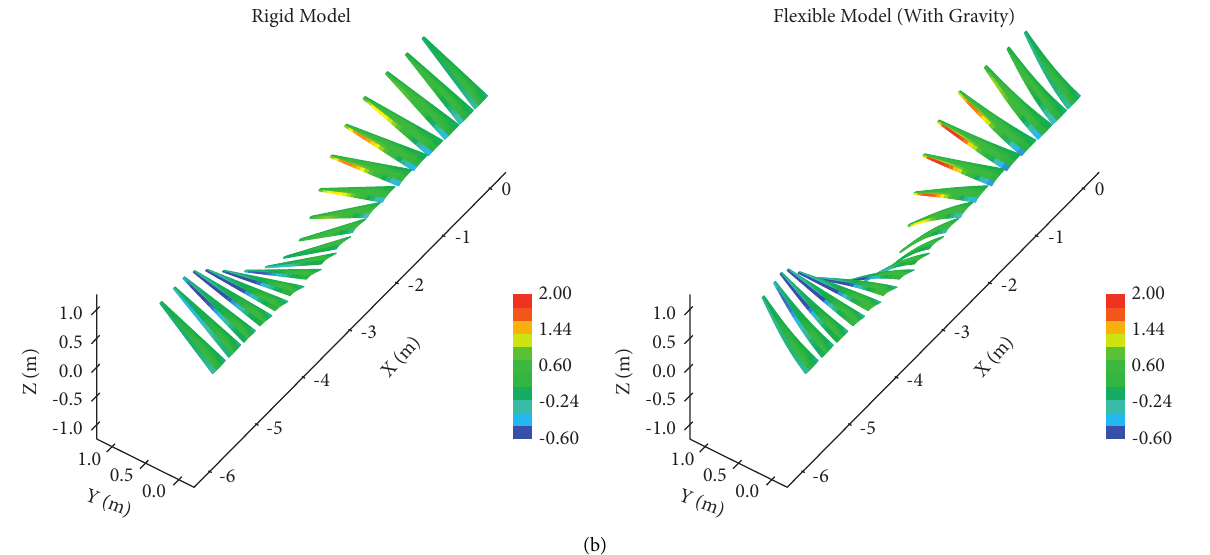
Figure 14: (a) Pressure distributions (N · m 2 ) and (b) force distributions (N) on rigid and flexible wings in a